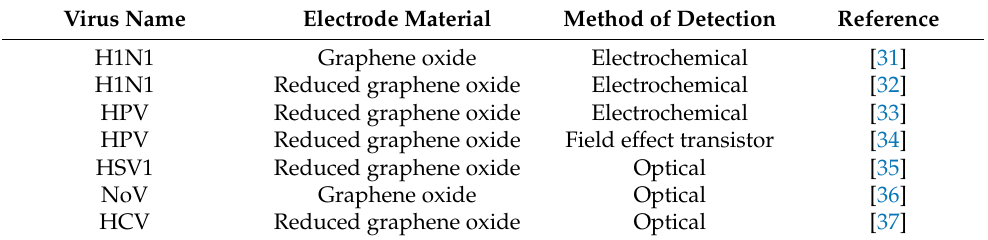
Table 1. Graphene-based detection for different viruses. (H1N1—haemagglutinin type 1 and neu- raminidase type 1 influenza virus, HPV—human papilloma virus, HSV1—herpes simplex virus 1, NoV—norovirus, HCV—hepatitis C